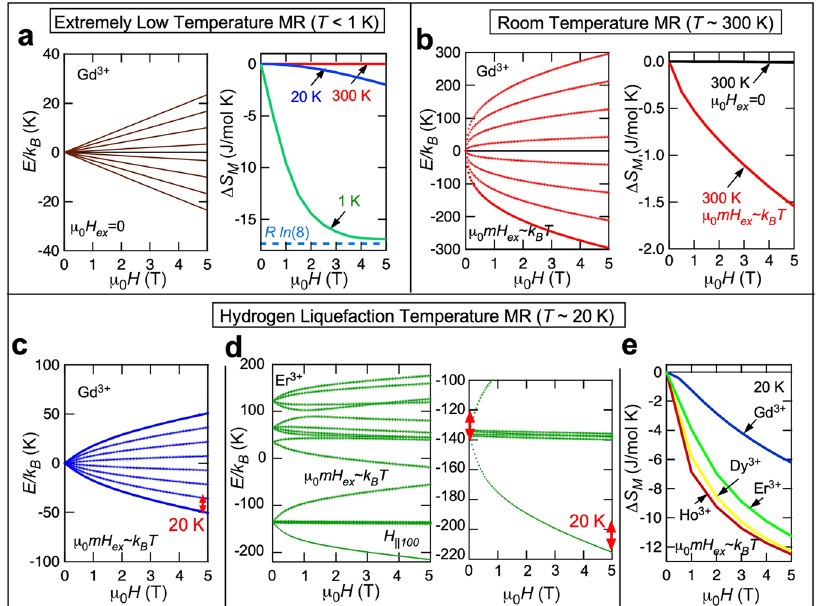
Fig. 1 Summary of the relationship between Zeemann splitting of energy level and magnetic entropy change for different temperature ranges. Zeemann splitting of energy level and magnetic entropy change of Gd 3 + at a T = 1 K, b T = 300 K, and c T = 20 K. μ 0 mH ex denotes the exchange interaction energy. In d Zeemann splitting of Er 3 + and e magnetic entropy changes for Dy 3 + , Ho 3 + , and Er 3 + for ideal case of crystalline electric fi eld parameters when compared to the Gd 3 + case. They are calculated with the mean- fi eld theory, which is described in the main text.